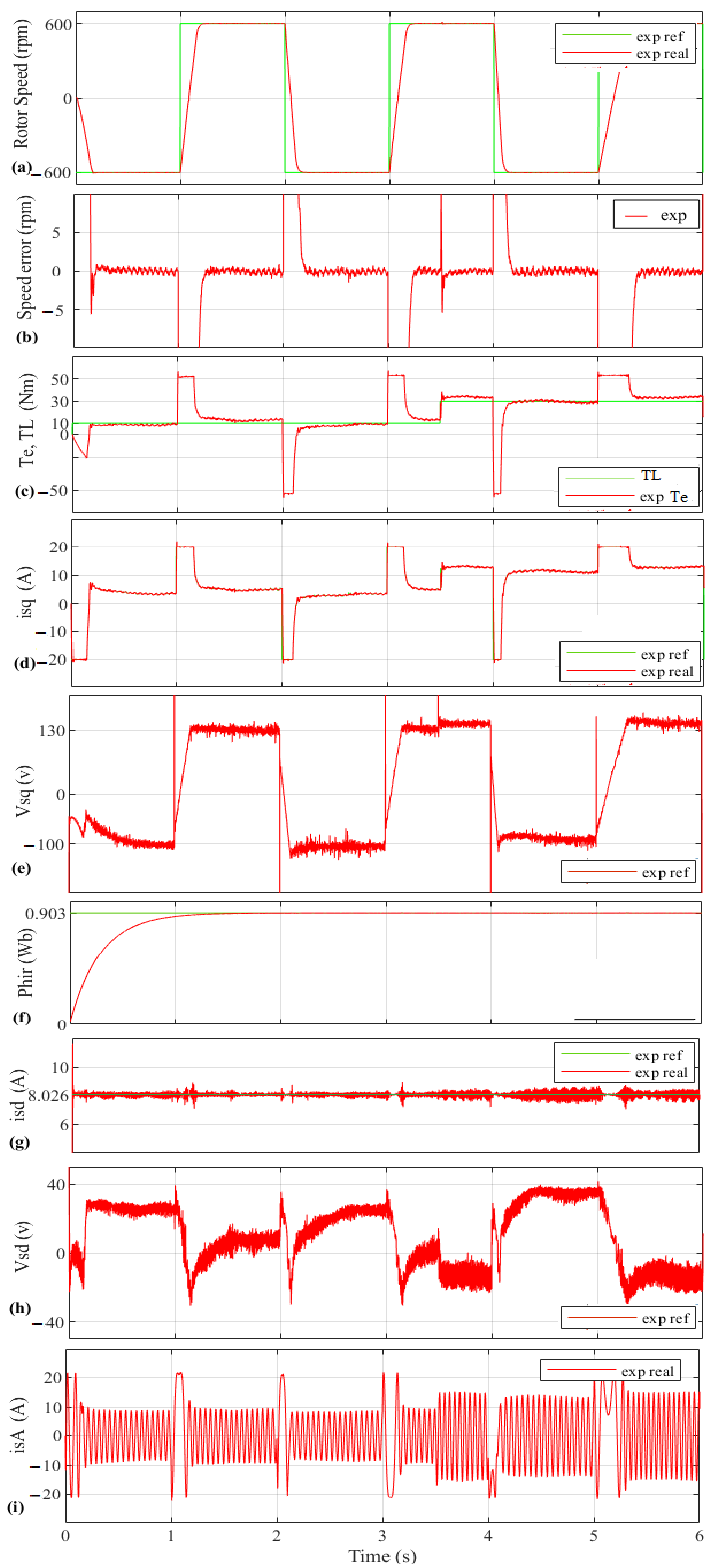
Figure 6. Experimental results with 600 rpm reference speed and two load torque step changes (ISMC D2-T1): ( a ) Rotor speed, ( b ) Speed error, ( c ) T e , T L , ( d ) Torque current, ( e ) v sq , ( f ) Rotor flux, ( g ) Rotor flux current, ( h ) v sd and ( i ) Stator